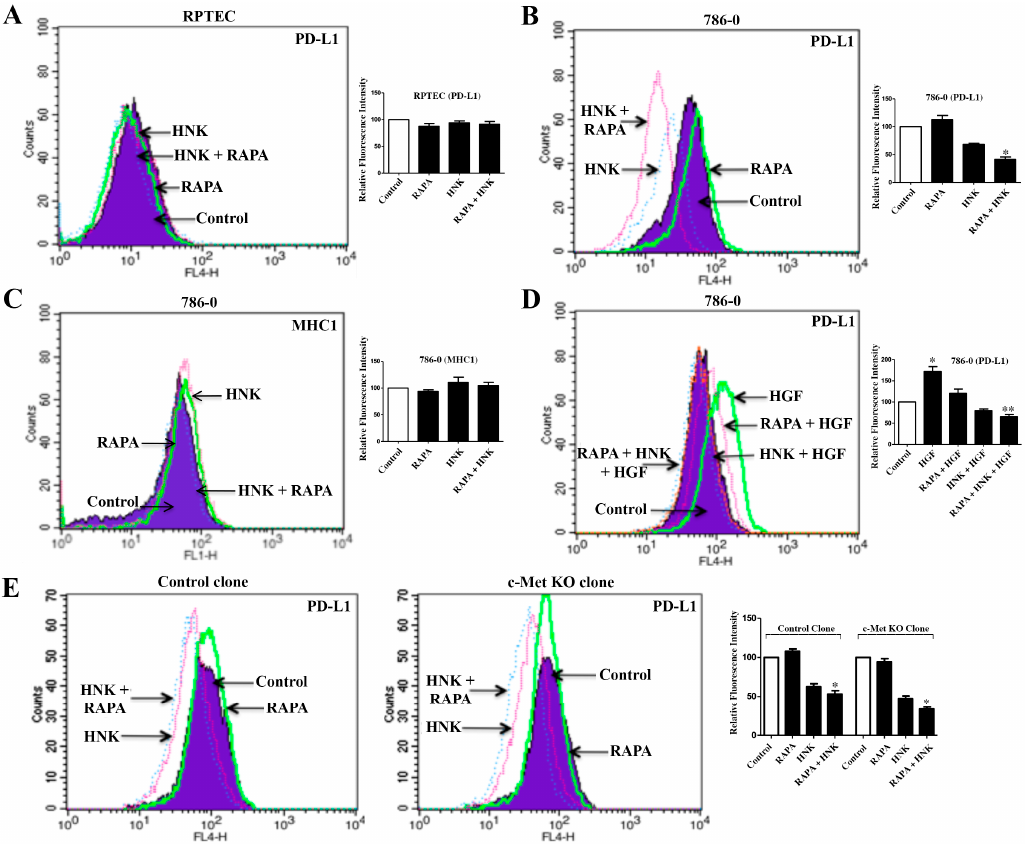
Figure 6. Honokiol (HNK) + Rapamycin (RAPA) combination decreases c ‐ Met ‐ induced PD ‐ L1 expression in renal cancer cells. ( A ) RPTEC and ( B – C ), 786 ‐ 0 cells were treated with RAPA (15 μ M) and Honokiol (40 μ M) either alone or in combination for 48h. Following treatment, cells were stained with PD ‐ L1/MHC1 antibody and the cell surface expression of PD ‐ L1/MHC1 were analyzed by flow cytometry. ( D ) 786 ‐ 0 cells were treated with RAPA (15 μ M) and Honokiol (40 μ M) either alone or in combination and in the presence of HGF (50 ng/mL) or vehicle for 48 h. Following treatment, the cell surface expression of PD ‐ L1 was analyzed by flow cytometry. ( E ) Control and c ‐ Met KO clones ( top and bottom panel respectively) were treated with RAPA (15 μ M) and Honokiol (40 μ M) either alone or in combination for 48 h, and the cell surface expression of PD ‐ L1 was analyzed by flow cytometry. ( A – E ), data shown are representative of three independent experiments; and the bar graphs presented next to histogram overlays represent the quantification of changes in relative fluorescence intensities compared with the control (control values were considered as 100%). The columns represent the mean ± S.D. of duplicate experimental readings. In ( B ), * p < 0.05 compared with control; in ( D ), * p < 0.05 compared with control and ** p < 0.05 compared with HGF ‐ treated cells; in ( E ), * p < 0.05 compared with respective controls.